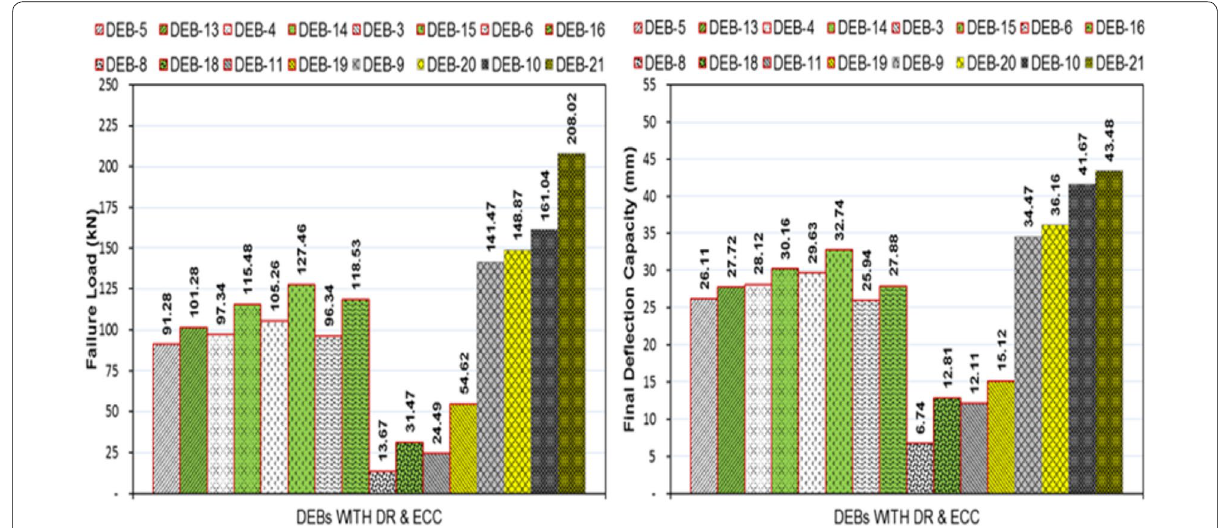
Fig. 15 Failure load and final deflection in the first and second group (For DEB-5,-13,-4,-14,-3,-15,-6,-16,-8,-18,-11,-19,-9,-20,-10 and